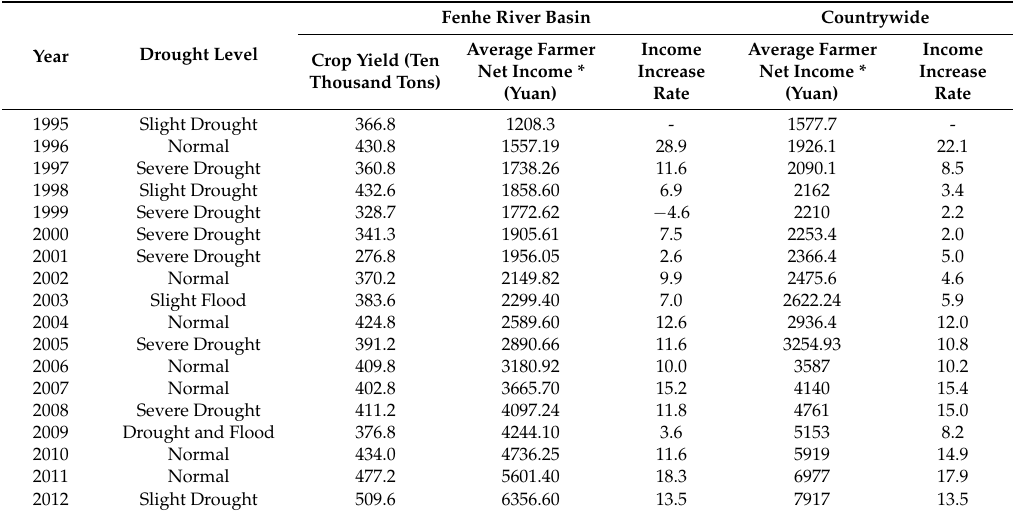
Table 6. Crop yields and farmer income in the Fenhe River basin from 1997 to